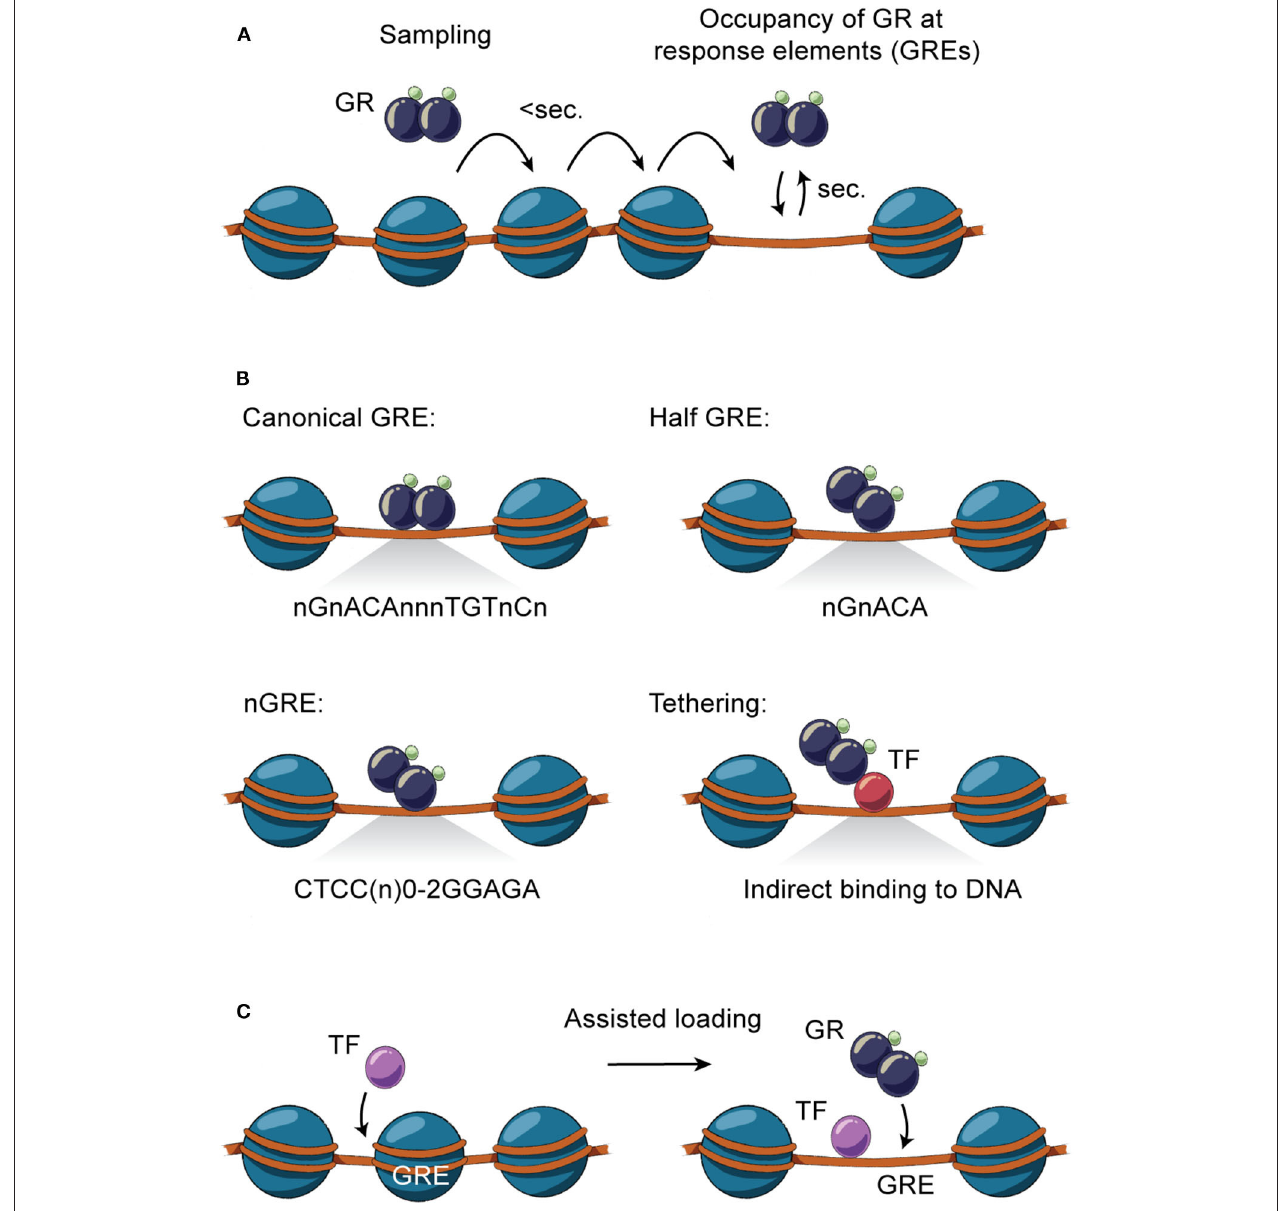
FIGURE 2 | Direct and indirect GR-DNA interactions. (A) GR interacts dynamically with DNA. Freely diffusing GR occupies chromatin with residence time in milliseconds, whereas GR binding at specific regions of chromatin is measured in the order of seconds. (B) GR interacts directly with DNA by binding to canonical GRE (nGnACAnnnTGTnCn), half-sites (nGnACA) and nGRE (CTCC(n) 0 − 2 GGAGA) or indirectly by tethering to DNA-bound TFs by protein-protein interactions. (C) TFs can assist the loading of GR, or vice versa, by facilitating an accessible chromatin environment at the regulatory